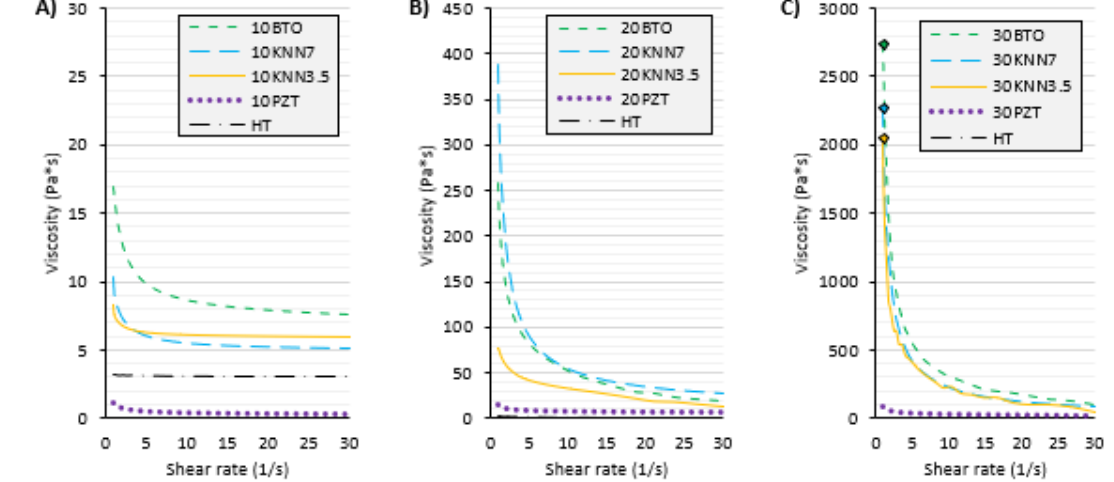
Figure 7. Viscosity values of ceramic/photopolymer suspensions over the shear rate: ( A ) 10 vol.% ceramic; ( B ) 20 vol.% ceramic; ( C ) 30 vol.% ceramic.